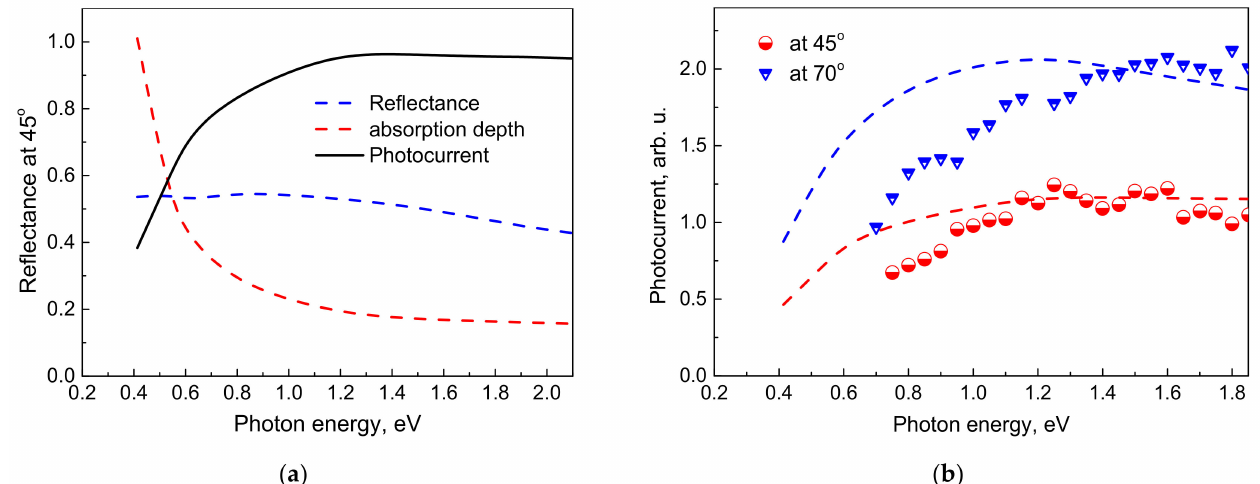
Figure 8. ( a ) THz photocurrent spectrum calculated using Equation (2) and the reflectance (blue line) and absorption depth (red line) spectra. ( b ) THz photocurrent spectra measured on 100 nm thick Bi on Au layer excited at different illumination angles. Points—experiments; dashed